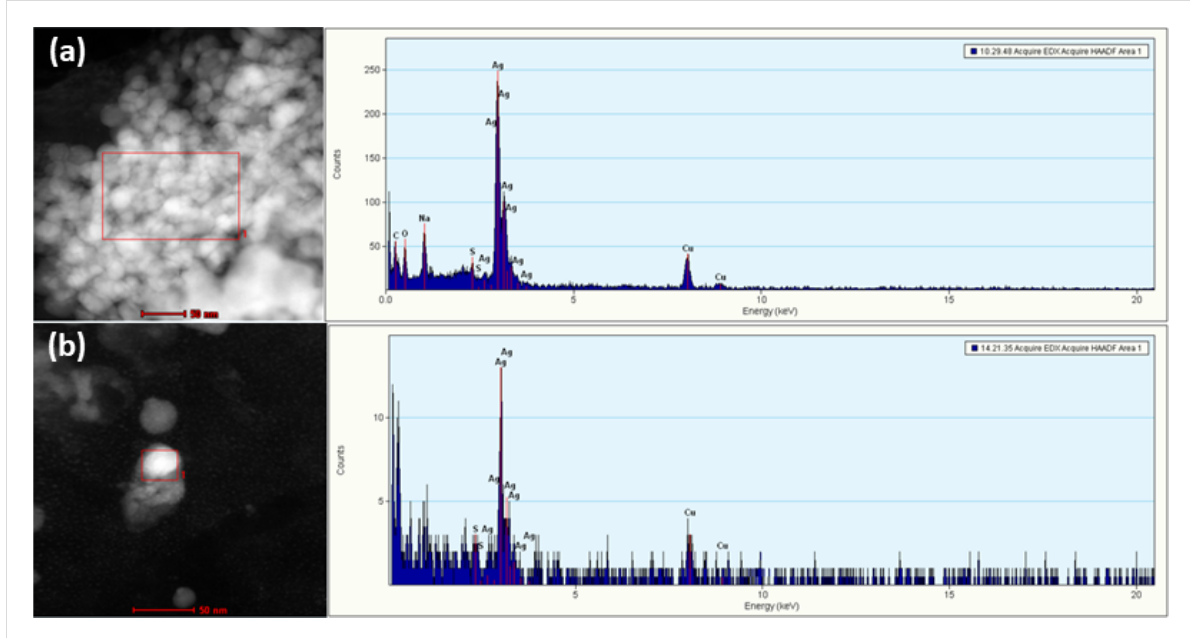
Figure 7: HAADF–STEM images of the newly formed AgNPs in (a) mCYS and (b) mGSH media. The media abbreviations are explained in Table 1. The areas identified by red rectangles represent areas examined by EDX. The corresponding EDX spectra are given next to the respective HAADF–STEM images.